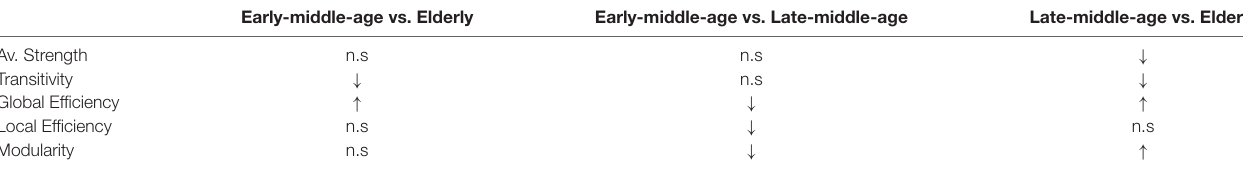
TABLE 3 | Differences in global network measures from the cognitive connectome across age groups. Early-middle-age vs.